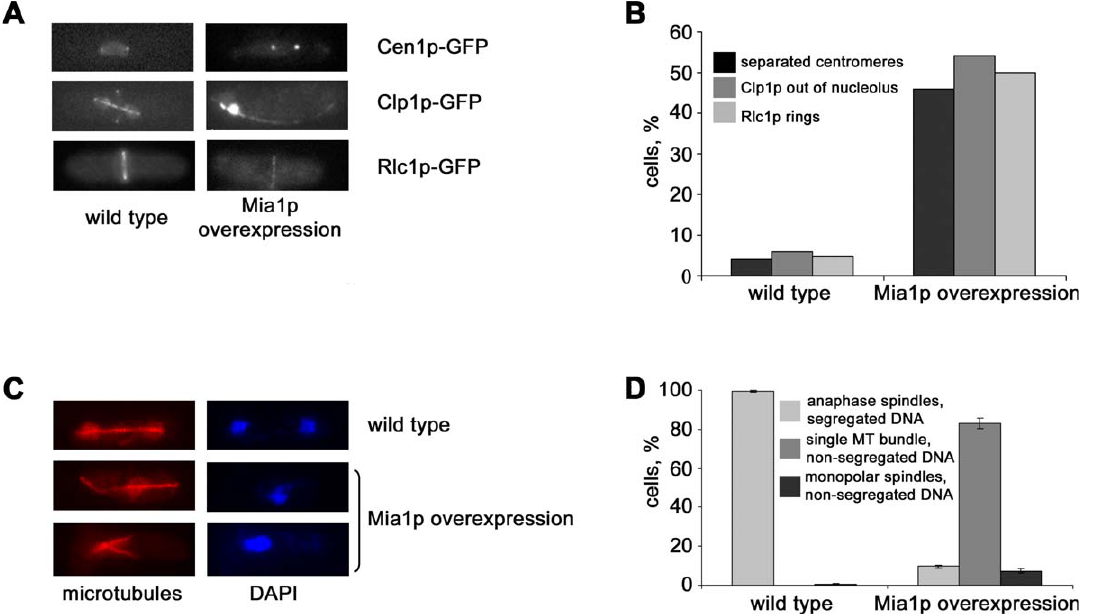
Figure 1. Fission Yeast Cells Overexpressing Mia1p Arrest in Mitosis with Fully Extended Spindles (A) The centromere markers, Cen1-GFP, Clp1-GFP, and Rlc1p-GFP, exhibit late mitotic localization in cells overexpressing Mia1p. Shown are single maximum-intensity reconstructions of live cells. (B) Graph quantifying the proportion of cells exhibiting mitotic localization of marker proteins ( n ¼ 100). (C) Immunofluorescence images of wild-type and Mia1p-overexpressing cells using anti– a -tubulin antibodies and the DNA dye, DAPI. (D) Graph quantifying the proportion of mitotic cells exhibiting wild-type or abnormal spindle architecture ( n ¼ 300). MT, microtubule.